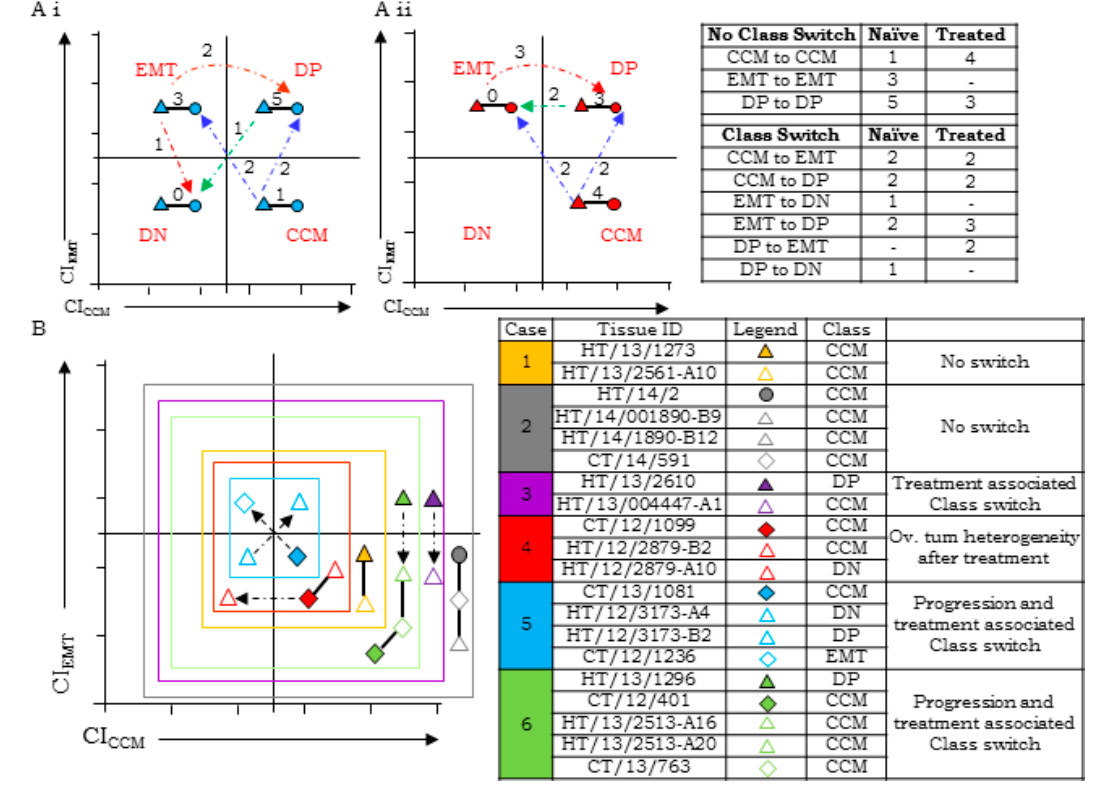
Figure 3. Class switching detected in cases with ( A ) ovarian and omental tumors tissues of (i) chemo-naïve ( n = 17) and (ii) chemo-treated ( n = 16) patient cohort; ( B ) class switching in tumors collected from patients ( n = 6) prior to chemo-treatment (filled shapes) and post chemo-therapy (empty shapes) as determined through ascites (diamond), primary tumor (triangle), and omentum (circle). EMT-epithelial to mesenchymal transition; DP-double positive; DN-double negative; CCM-cooperative cell migration.